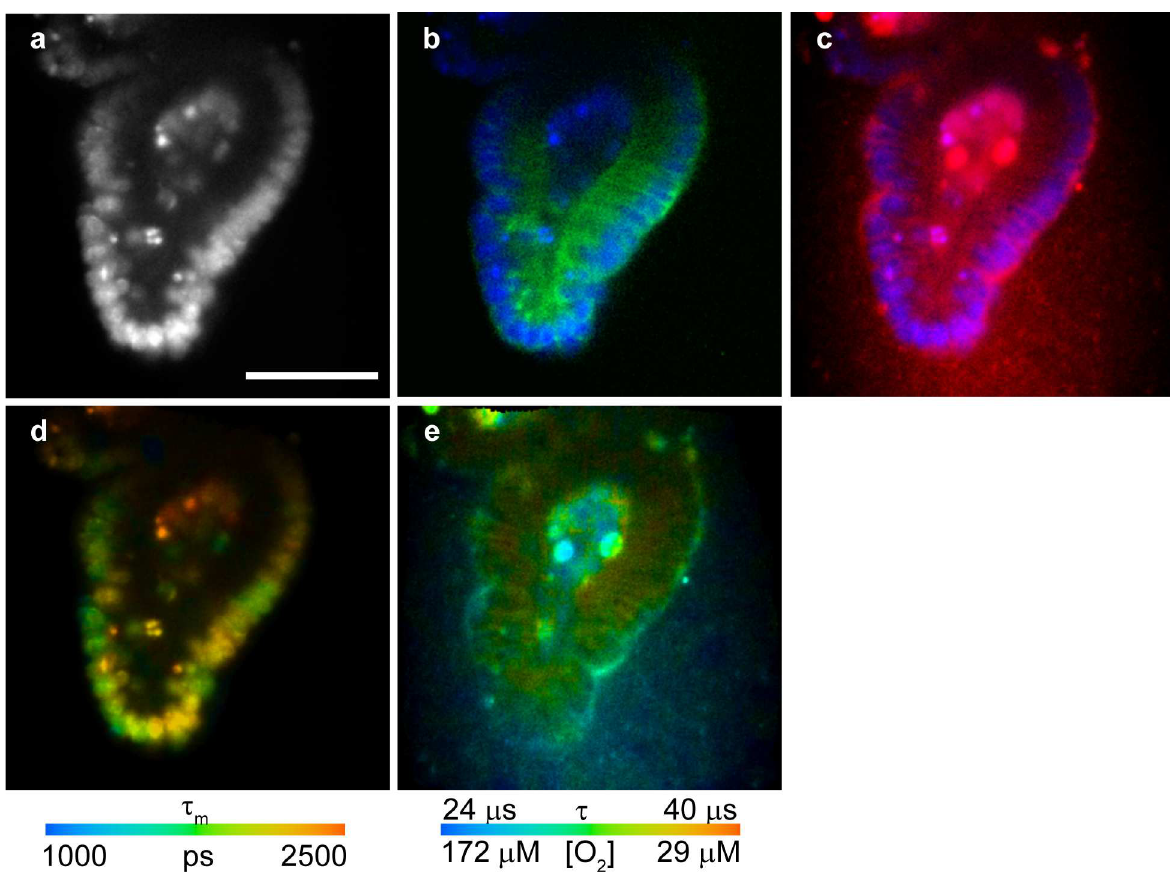
Fig 6. Multi-parametric FLIM imaging of mouse intestinal organoids. (a,b,c) Intensity images of HXT (a), HXT (blue) merged with lipid raft stain (green) (b), and HXT (blue) merged with cell-penetrating O 2 -sensitiveprobe Pt-Glc (red) (c). (d) HXT τ m image informingon cell proliferation(405 nm exc., 438–458nm em.). (e) τ m of Pt-Glc (405 nm exc., 635–675nm em.) informing on cell/tissue oxygenation. Scale bar is 50 μ